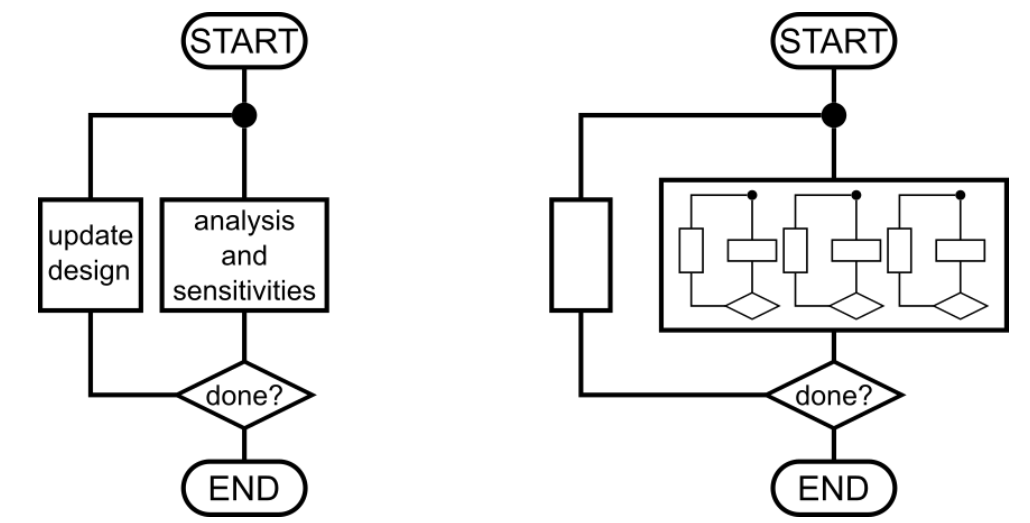
Figure 11. Comparison between a monolithic ( left ) and a distributed architecture ( right